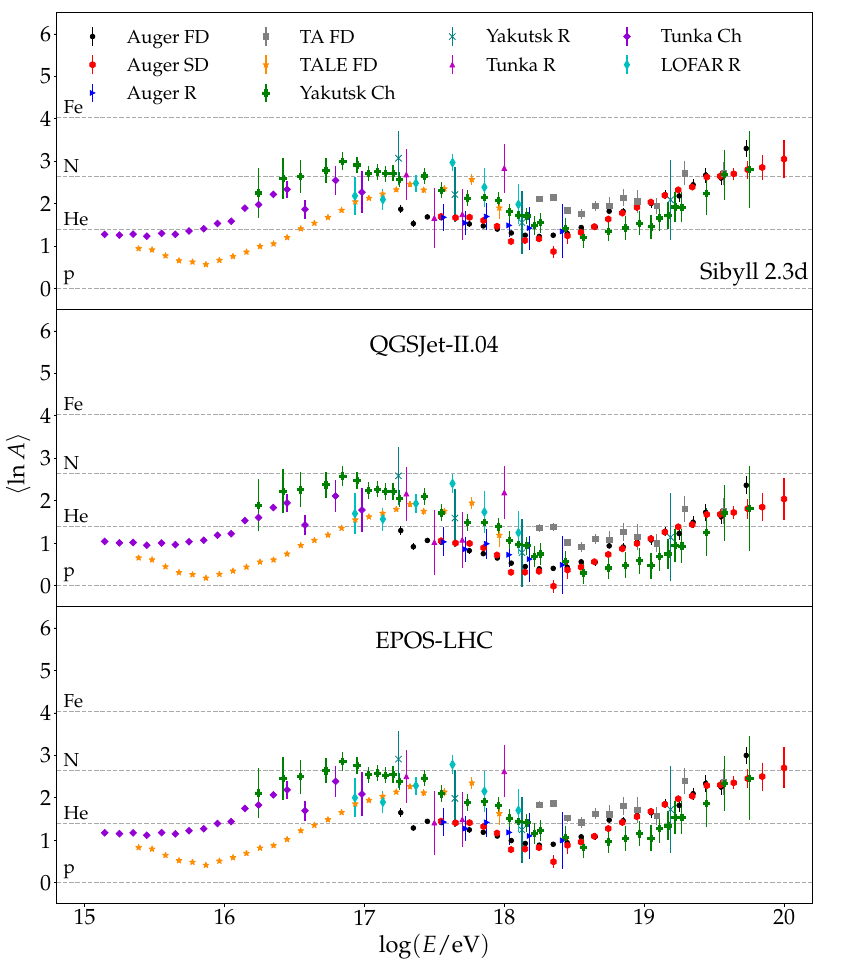
measured X max (cid:104) (cid:105)